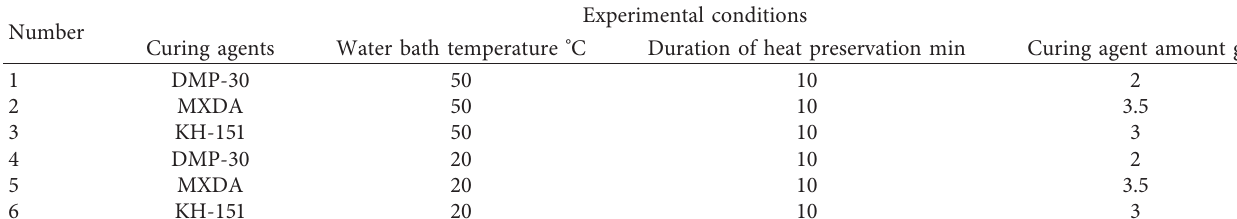
Table 2: Control experiments.